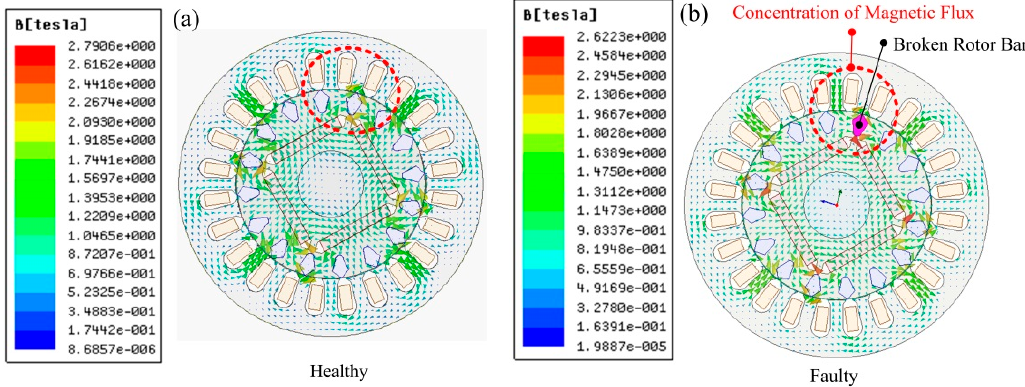
Figure 10. The magnetic flux line in the ( a ) healthy motor and ( b ) faulty motor (one BRB).